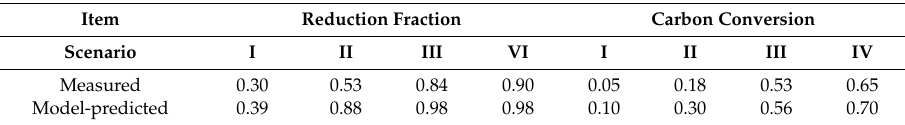
Table 5. Measured and model-predicted parameters of CCB after reacting for 30 min.